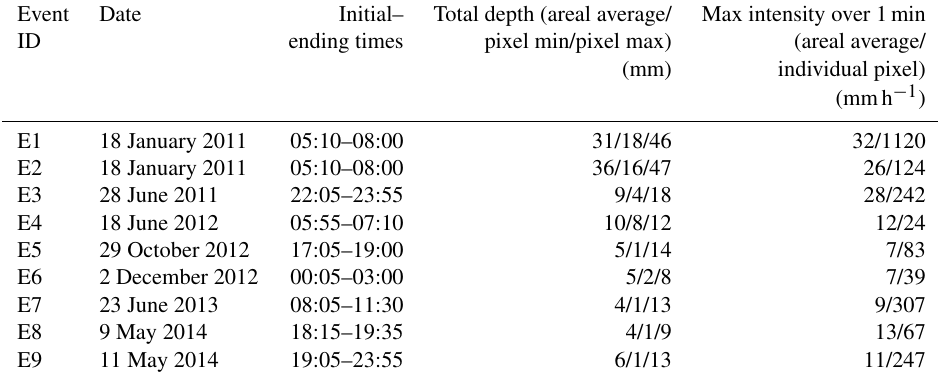
Table 3. Rainfall event